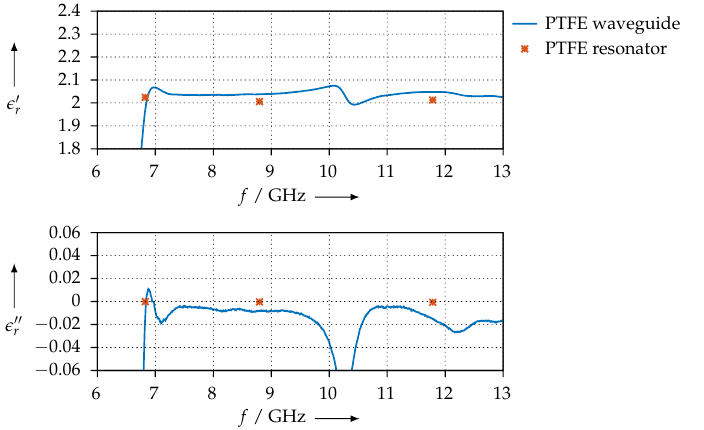
Figure 8. Extracted permittivity of the PTFE reference sample and comparison with the values that have been measured with the resonator method.